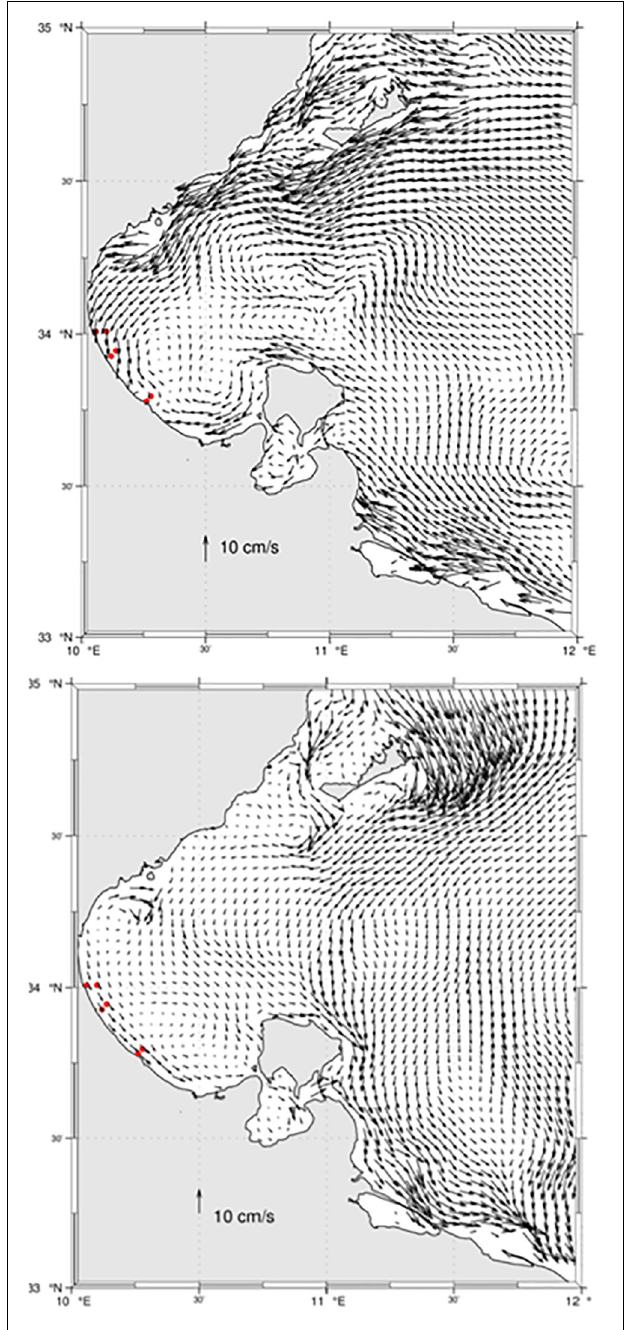
FIGURE 4 | The Gulf of Gabes surface circulation based on monthly mean velocity vectors averaged over upper 10 m in April (upper) and in November (lower). The sampling stations are indicated by red